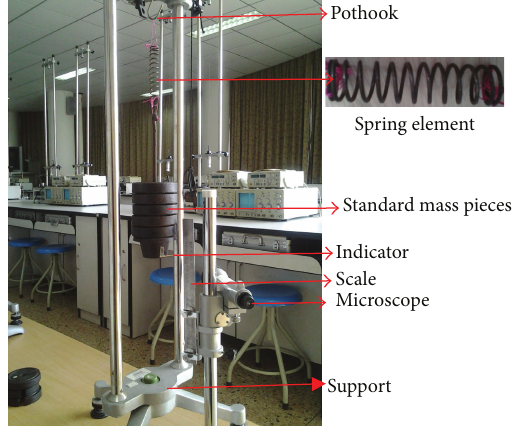
Figure 4: Test setup for the spring element